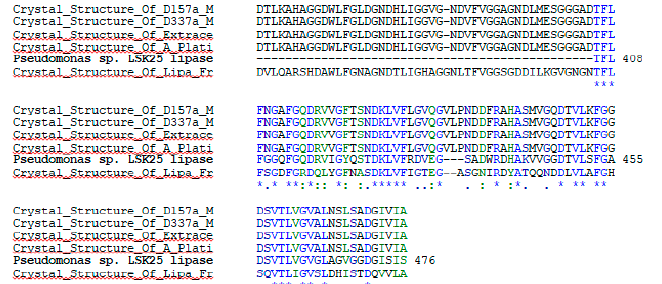
Figure 2. Alignment of the LSK25 lipase sequence with Pseudomonas lipases of known three-dimensional structure. Red highlight represents the catalytic triad: Ser 207 , Asp 255 , His 313 . Purple highlight underlined represents pentapeptide: GHSLG (GXSXG), (*) blue represents conserved residue; (:) green represents conservation of strong groups; (.) blue represents conservation of weak groups, absence of nucleotide for alignment (-). LSK25 lipase amino acid sequences were aligned with amino acid sequences of the crystal structures of D157A mutant of Pseudomonas sp. MIS38 lipase, D337A mutant of Pseudomonas sp. MIS38 lipase, extracellular lipase from Pseudomonas sp. MIS38, platinum-bound S445C mutant of Pseudomonas sp. MIS38 lipase [16,17] and LipA from Serratia marcescens [18].